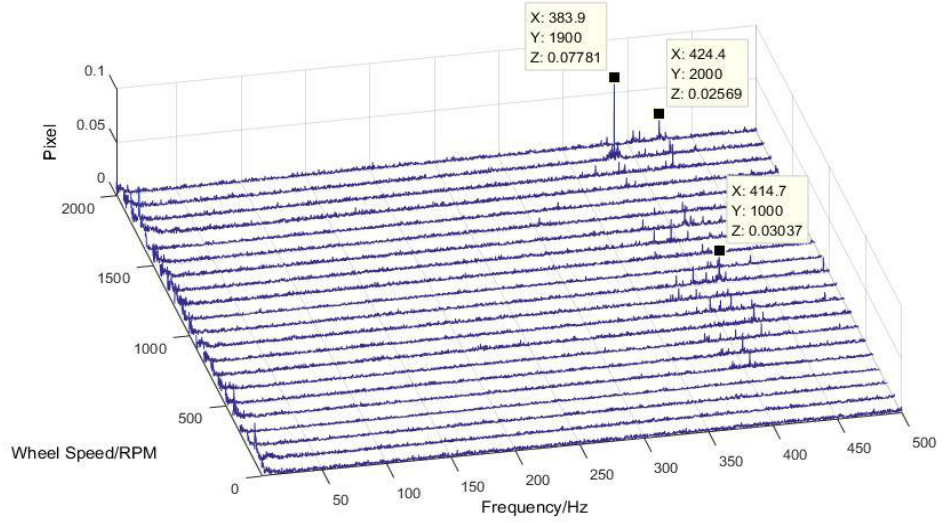
Figure 13. The pixel o ff set results of the imaging test in the frequency domain.